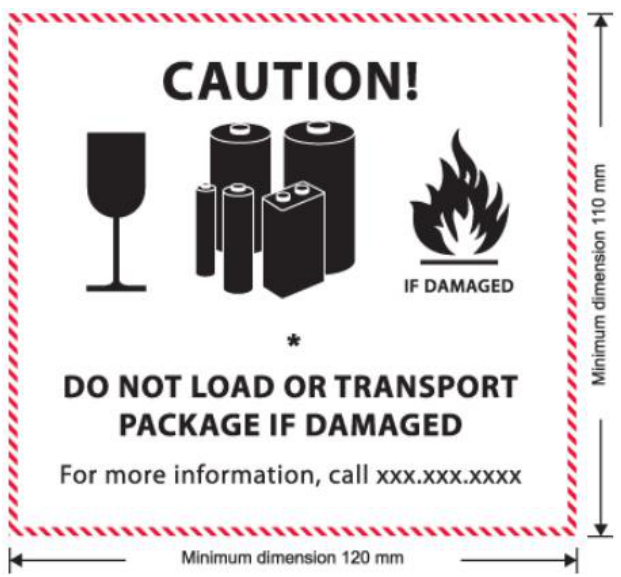
Figure 1. Labeling required for packages containing lithium-ion batteries or products with installed lithium-ion batteries to be shipped by air [2]. Reproduced with permission of the United Nations (UN).